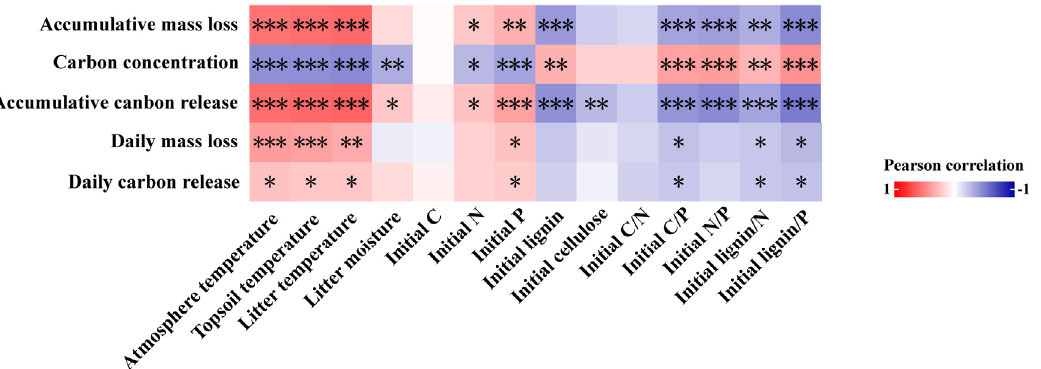
Figure 7. Pearson’s correlation analysis between the mass loss rate, carbon concentration, and release rate and the temperature, moisture, and initial nutrient parameters of foliar litter. * p < 0.05, ** p < 0.01, *** p < 0.001.